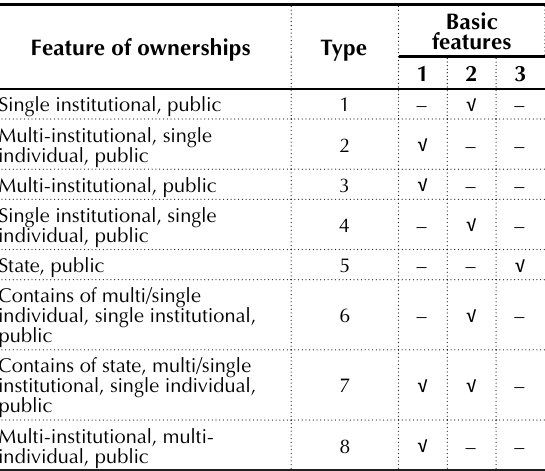
Table 1. The features of ownership